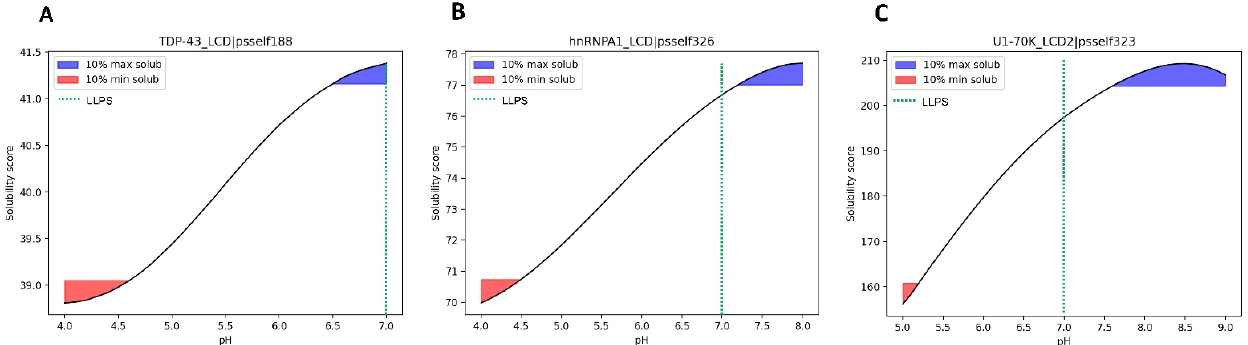
Figure 6. Predicted solubility curves at different pHs for the LCDs of TDP-43 ( A ), hnRNPA1 ( B ) and U1-70K ( C ). In all three cases, homotypic LLPS was observed at pH 7.0, a condition in which they display relatively high solubility scores.